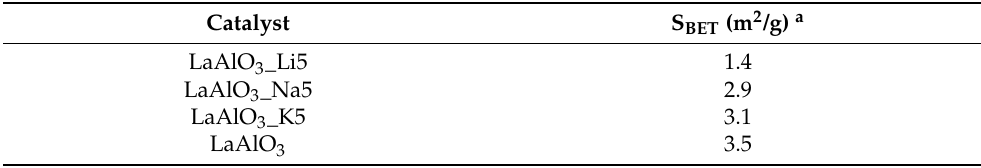
Table 1. Specific surface of LaAlO 3 _X5 (X = Li, Na, K) and LaAlO 3 catalysts. Catalyst